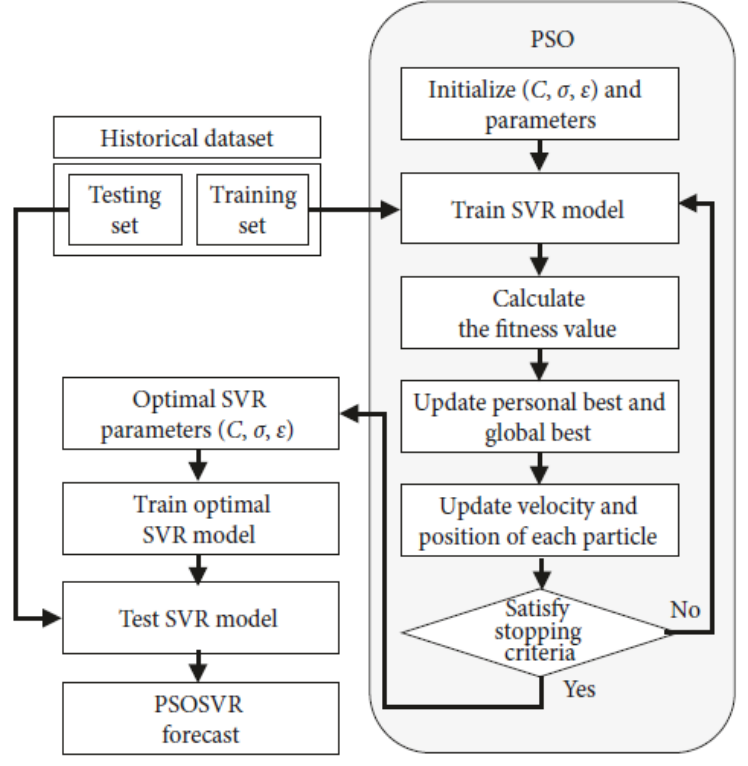
Figure 4. Process implementation